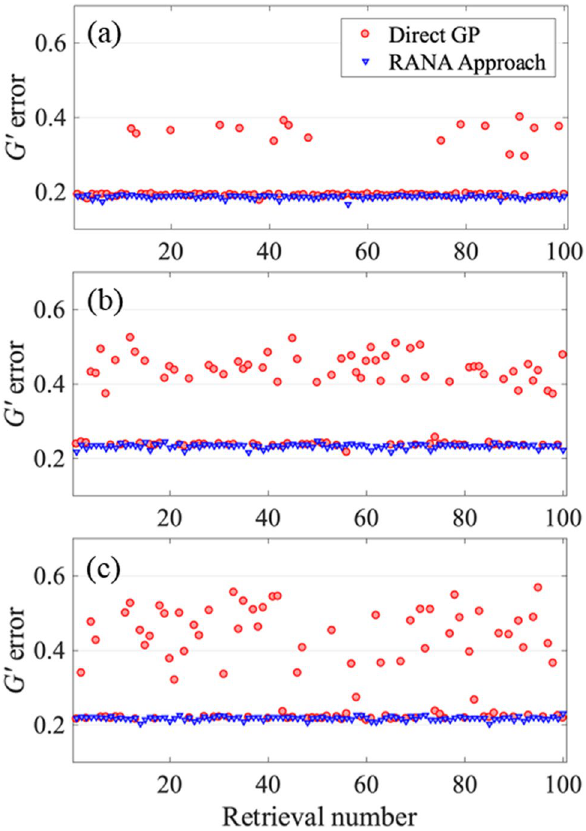
Figure 4. G ′ errors for retrieval of three noisy traces contaminated with 3% additive and 5% multiplicative noise corresponding to three unstable trains with average temporal FWHM of 26 fs ( a ), 54 fs ( b ), and 108 fs ( c ). The G ′ errors are obtained from recovery of the pulse for 100 runs using the RANA approach and standard GP algorithm from noise-reduced traces. Note that the RANA approach reliably yields the minimum G ′ error, while the GP algorithm alone does not, and additional runs of the algorithm are required. Finally, note that the effects of trace noise are small compared to those of pulse-shape